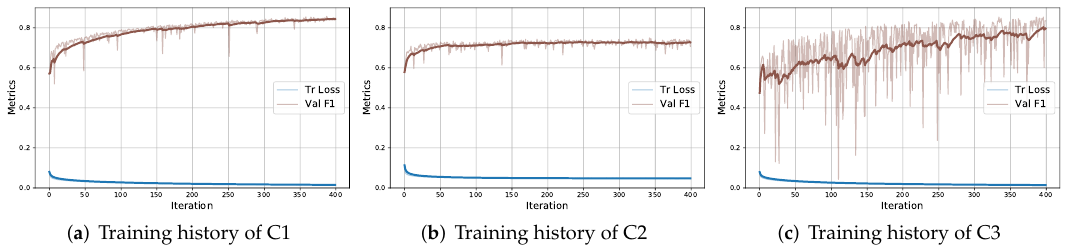
Figure 5. Evolution of training loss and F1 score on validation across the 400 training epochs on dataset D 2 . Bold lines indicate a running average with window of size